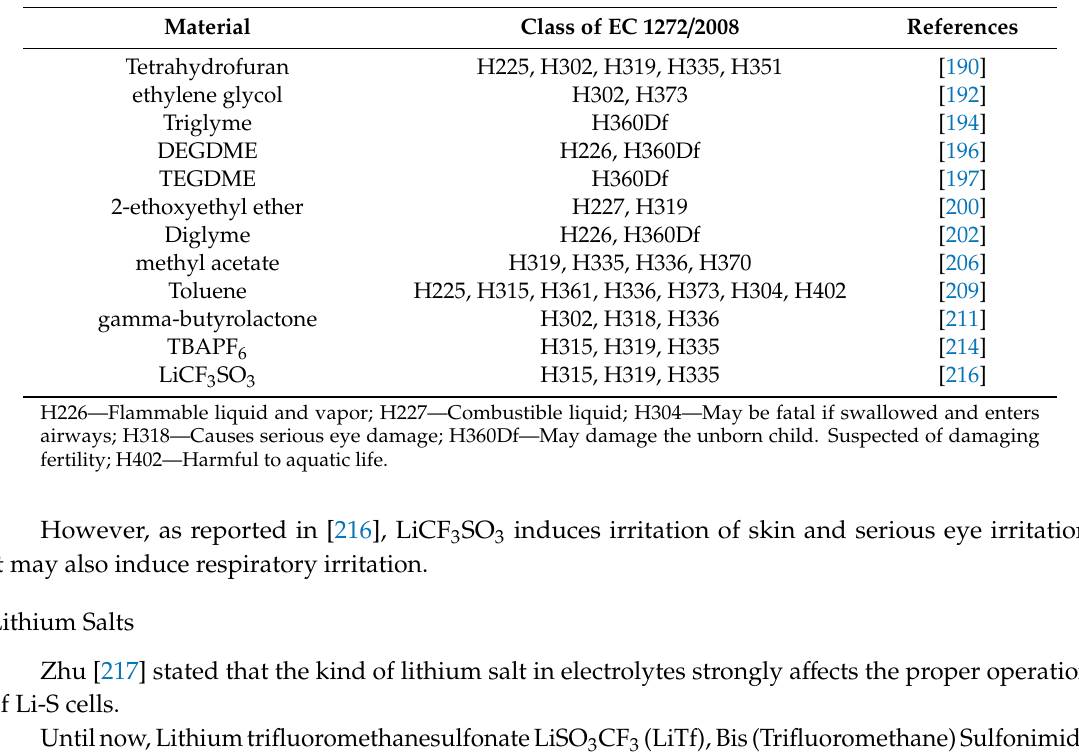
Table 6. Hazard statements of tetrahydrofuran, ethylene glycol, triglyme, DEGDME, TEGDME, 2-ethoxyethyl ether, diglyme, methyl acetate, toluene, gamma-butyrolactone, TBAPF 6 , and LiCF 3 SO 3